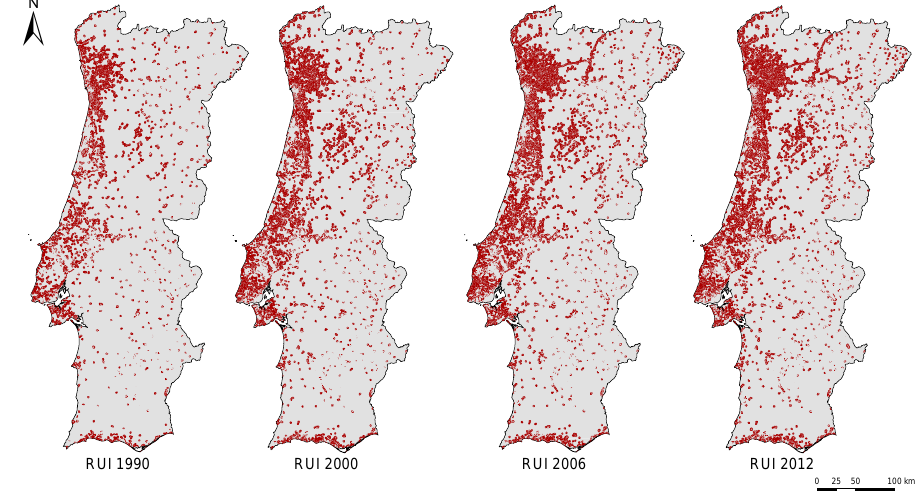
Figure 8. Maps of the rural–urban interface (RUI) in Portugal estimated for the different periods of investigation, and corresponding to the available CORINE Land Cover inventories (1990, 2000, 2006, and 2012).